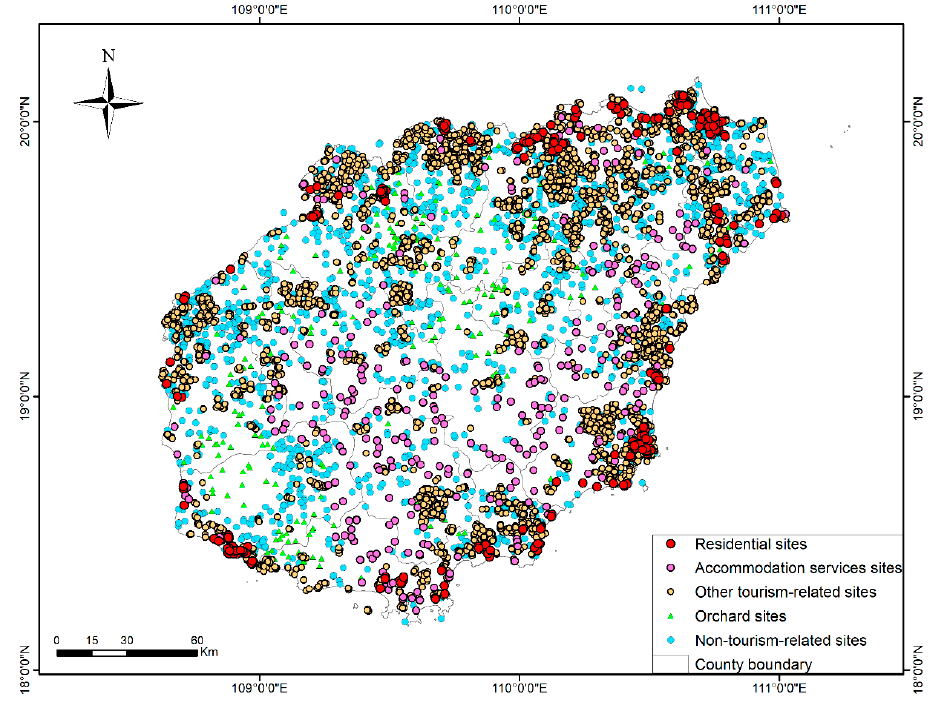
Remote Sens. 2020 , 12 , x Figure 5. The spatial distribution of two classes and four sub-classes sites. Figure 5. The spatial distribution of two classes and four sub-classes sites.